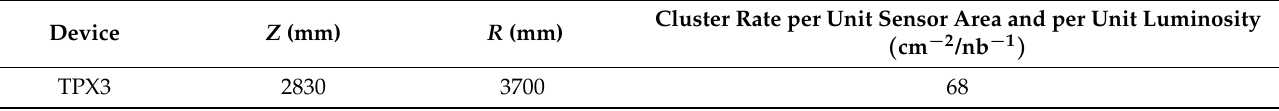
Table 31. TPX3 device location with respect to the interaction point. Z is the longitudinal distance from the interaction point along the beam axis and R is the distance from the beam axis. Their uncertainty is about 10mm. The approximate particle flux is given as an average of detector layers 1 and 2. Taken from Ref. [18].